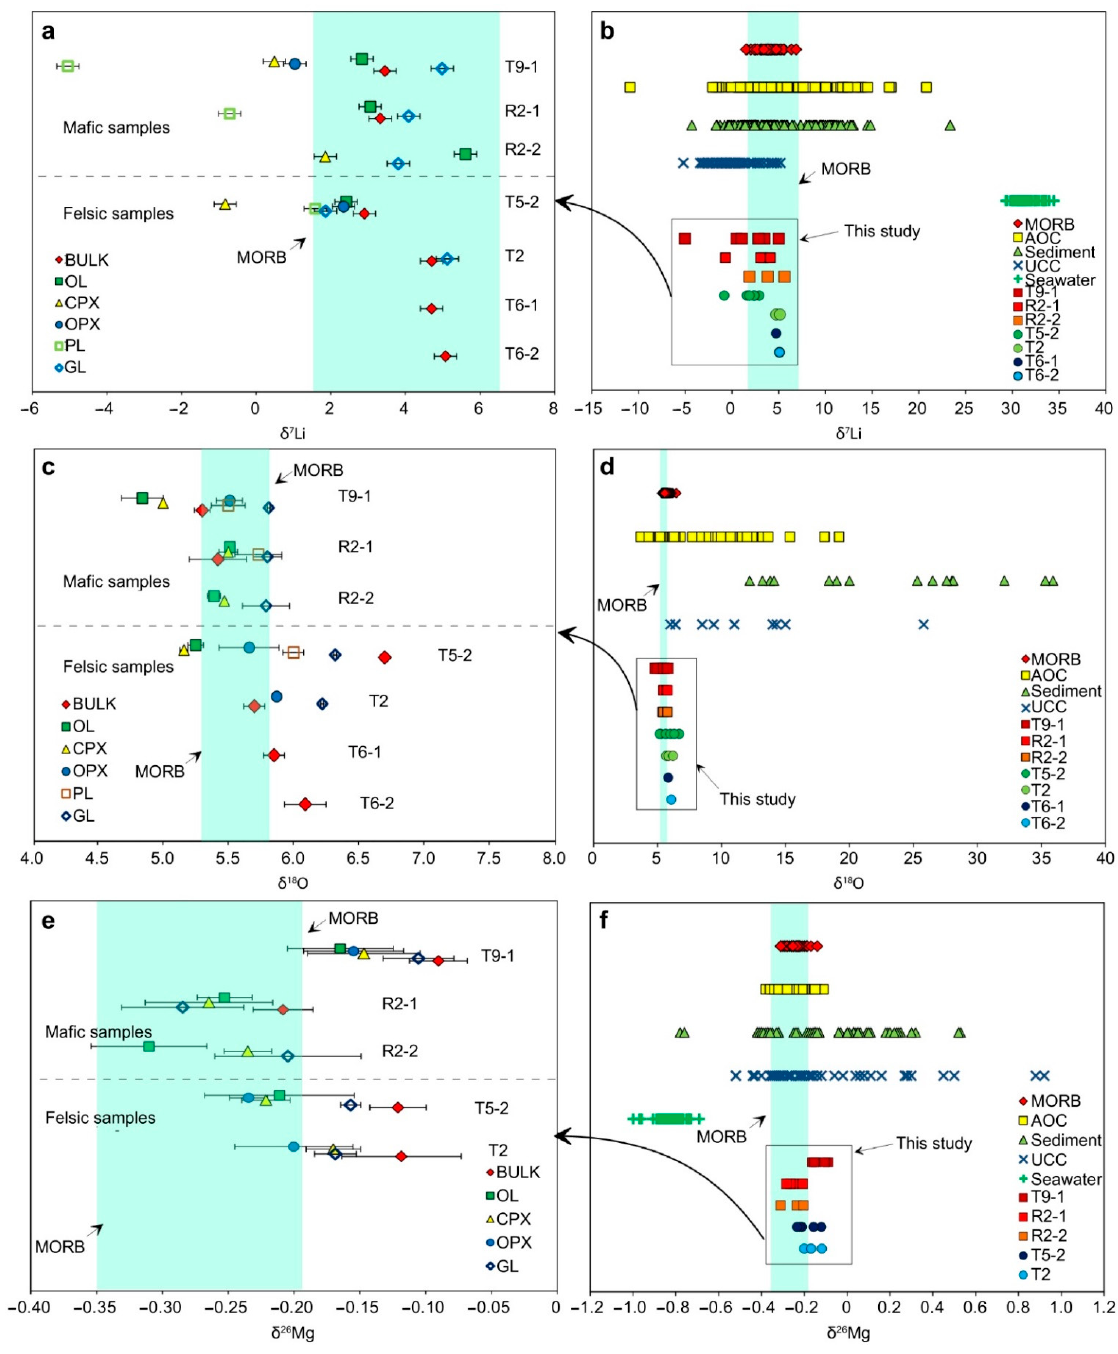
Figure 5. The δ 7 Li distributions of ( a ) the different whole-rock and mineral separates from the Okinawa Trough (OT) and ( b ) mid-ocean ridge basalts (MORBs), AOC, sediment, upper continental crust, and seawater. The δ 18 O distributions of ( c ) the different whole-rock and mineral separates from the OT and ( d ) MORBs, AOC, sediment, and upper continental crust. The δ 26 Mg distributions of ( e ) the different whole-rock and mineral separates from the OT and ( f ) MORBs, AOC, sediment, upper continental crust, and seawater. The MORB δ 7 Li range is from [22,33,91–93]. The AOC δ 7 Li data are from [4,22,25,94]. The sediment δ 7 Li data are from [3,4,25,27,95–97]. Upper continental crust (UCC) δ 7 Li data are from [98]. The MORB δ 18 O range is from [99–101]. AOC δ 18 O data are from [102,103]. Sediment δ 18 O data are from [104]. UCC δ 18 O data are from [105]. The MORB δ 26 Mg range is from [106,107]. AOC δ 26 Mg data are from [39]. Sediment δ 26 Mg data are from [108]. UCC δ 26 Mg data are from